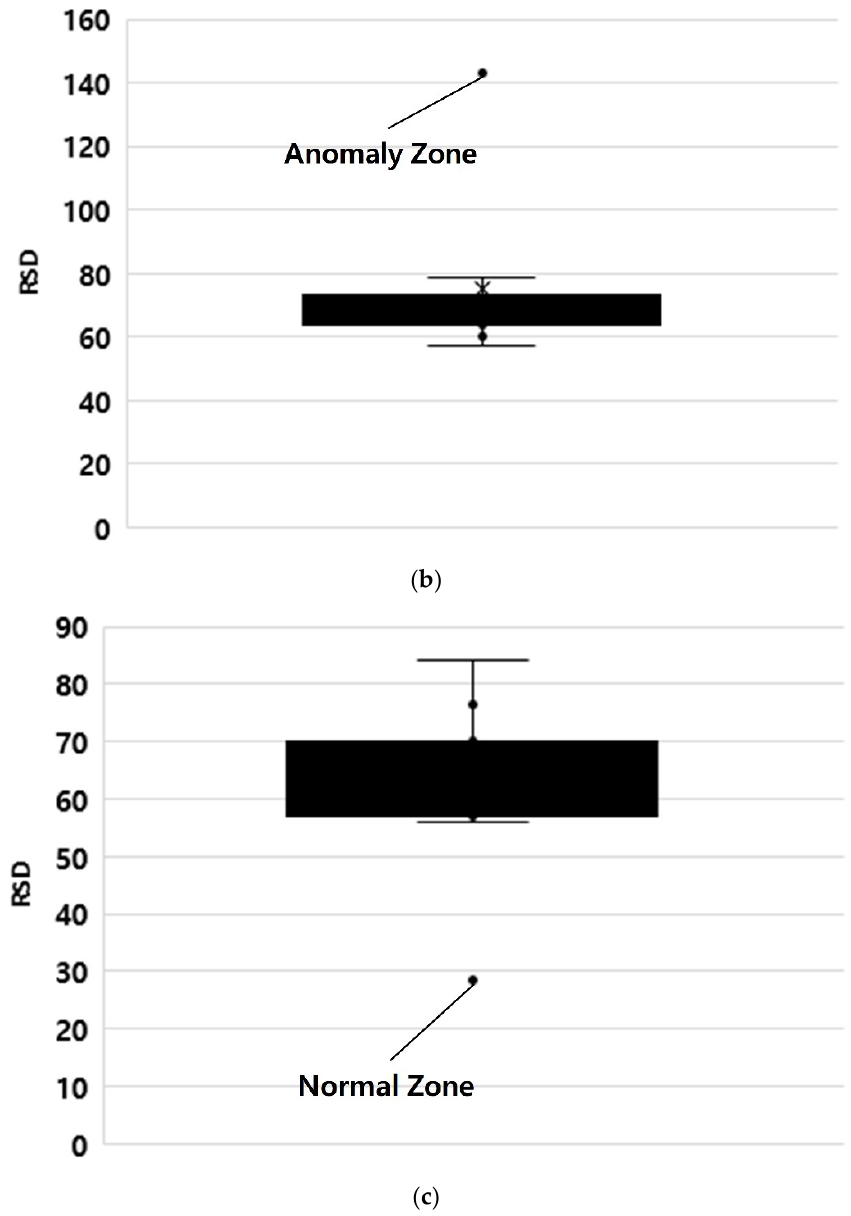
Figure 17. Verification of anomaly depth by the RSD method using a box plot. ( a ) Absence of anomaly zone (Section No. 1). ( b ) Existence of one small anomaly zone (Section No. 3). ( c ) Existence of more than one or a large anomaly zone (Section No. 2).